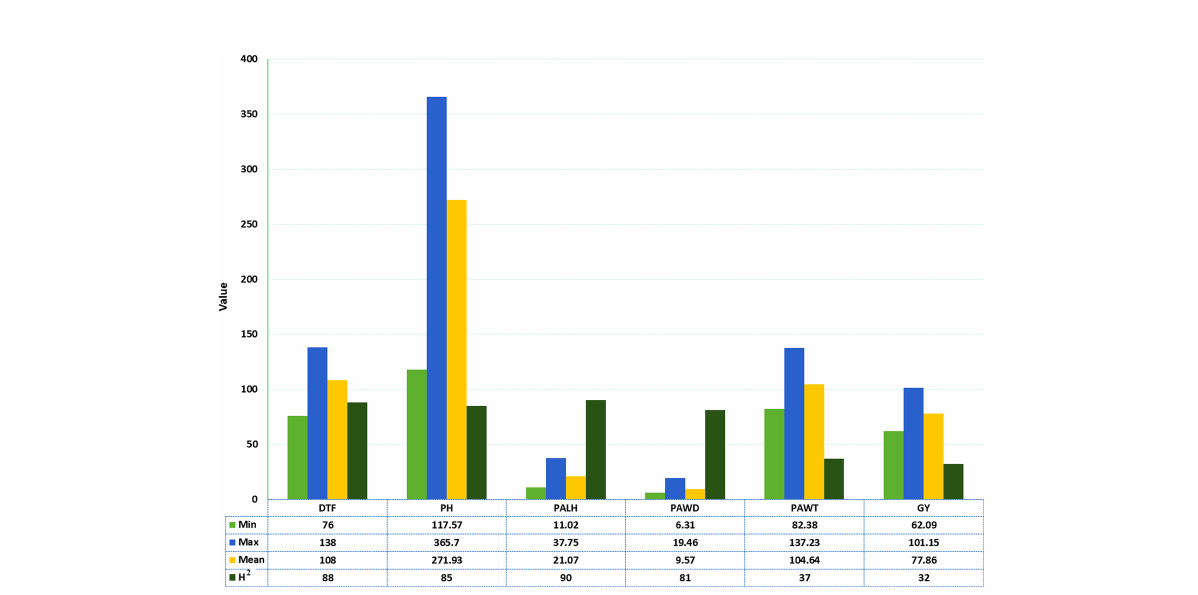
FIGURE 1 Descriptive statistics and broad-sense heritability of the six phenotypic traits for the sorghum accessions grown at three locations. MIN, Minimum; MAX, Maximum; H 2 , Broad-sense heritability in percent; DTF, Days to fl owering; PH, Plant height in cm; PALH, Panicle length in cm; PAWD, Panicle width in cm; PAWT, Panicle weight in g; GY, Grain yield in